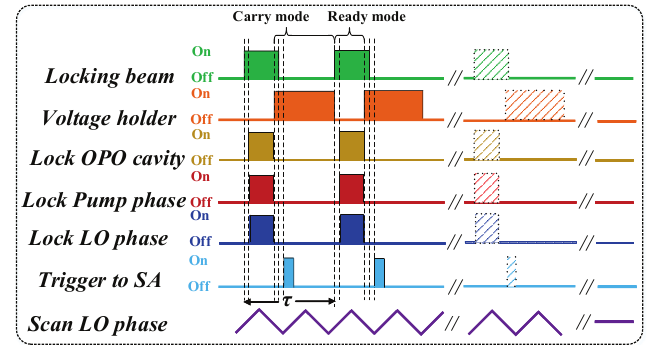
Figure 3. Time sequence of the experimental cycle. SA, spectrum